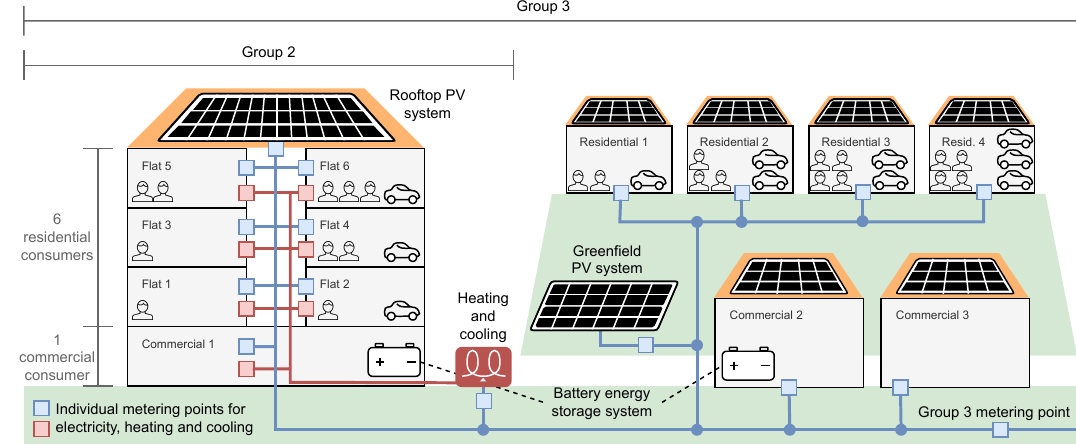
Figure 1. Building and community set-up.